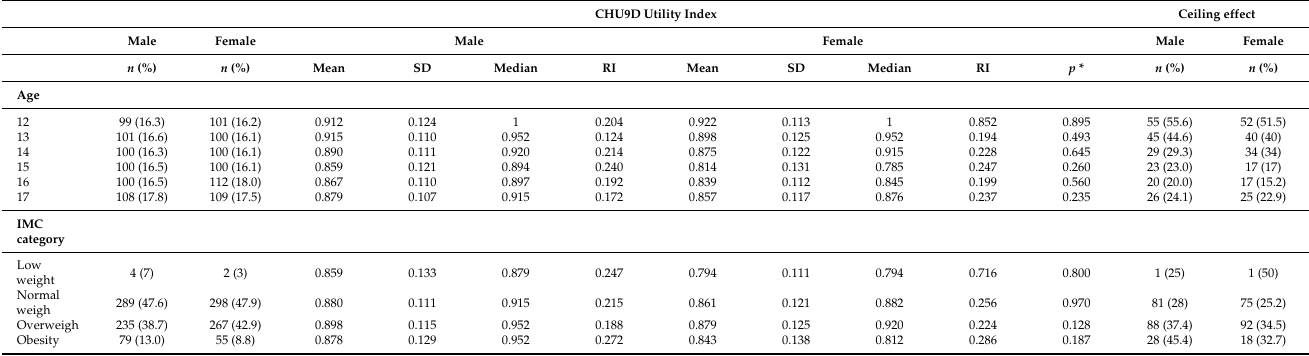
Table 3. Study sample characteristics. CHU9D adolescents’ population normative values by